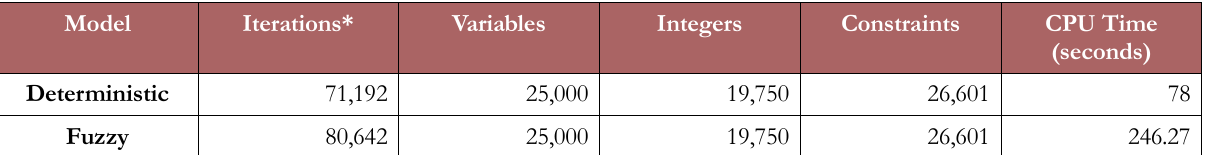
Table 2. Efficiency of the computational